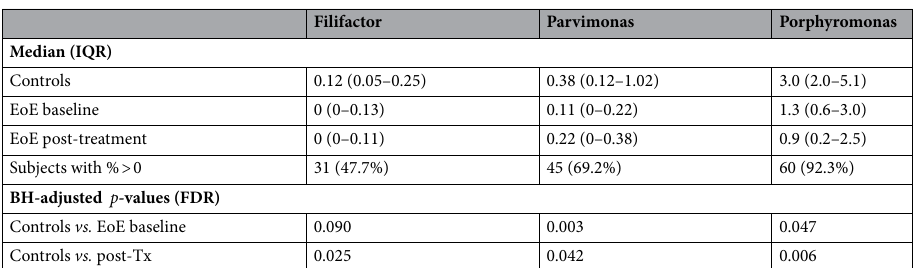
Table 2. Differential testing of microbial relative abundance. Median and interquartile range (IQR) of each group for the three genera that showed significant differences and percentage of subjects (out of 65) in which each genus was detected. Output adjusted p -values (Benjamini–Hochberg correction) of the statistical comparisons are also provided. EoE: eosinophilic oesophagitis; post-Tx: EoE patients after treatment; BH: Benjamini–Hochberg correction; FDR: false discovery